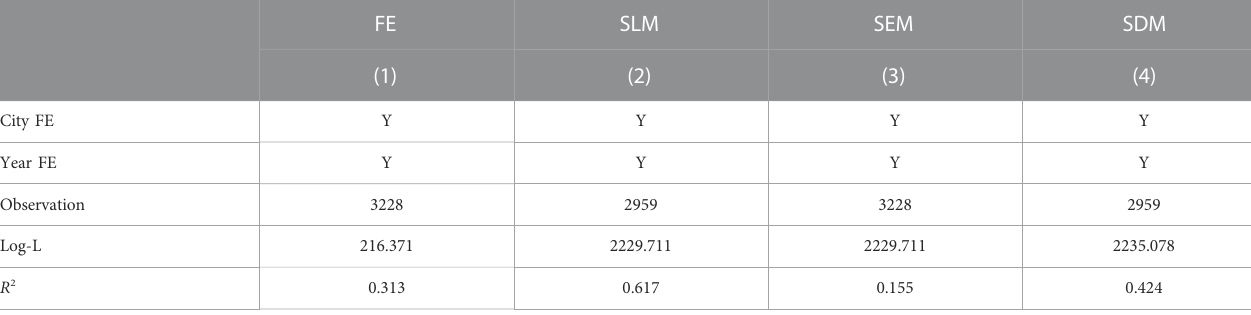
index. Green innovation is measured by the logarithm of the total number of green invention patents and green applicable patents of city i in year t . Industrial upgrading is measured by the ratio of tertiary sector output to secondary sector output of city i in year t . The results of the mechanism test are shown in Table 5.